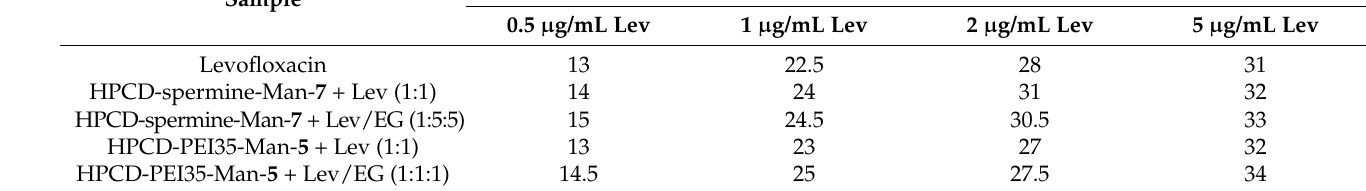
Table 5. Diameters of zones of antibacterial action of complex formulations of levofloxacin and adjuvants (eugenol and apiol). E. coli (NCIB 12210). pH 7.4 (0.01 M PBS), 37 ◦ C, 24 h of